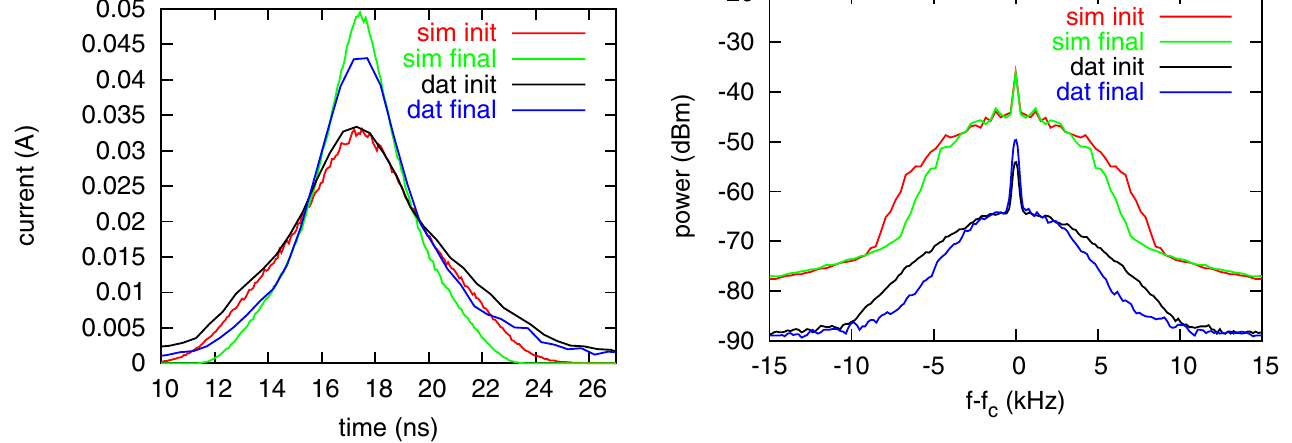
FIG. 9. (Color) Comparison of initial and final wall current monitor data with simulations using 10 6 macroparticles. The red and green lines are the simulated profiles before and after cooling, respectively. The black and blue lines are the experi- mental data before and after cooling, respectively.